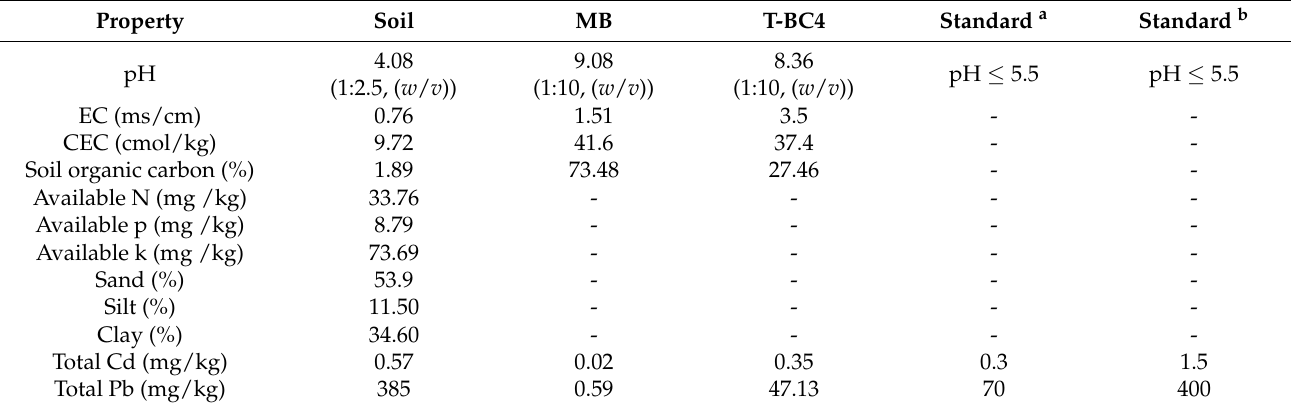
Table 1. Properties of the soil and